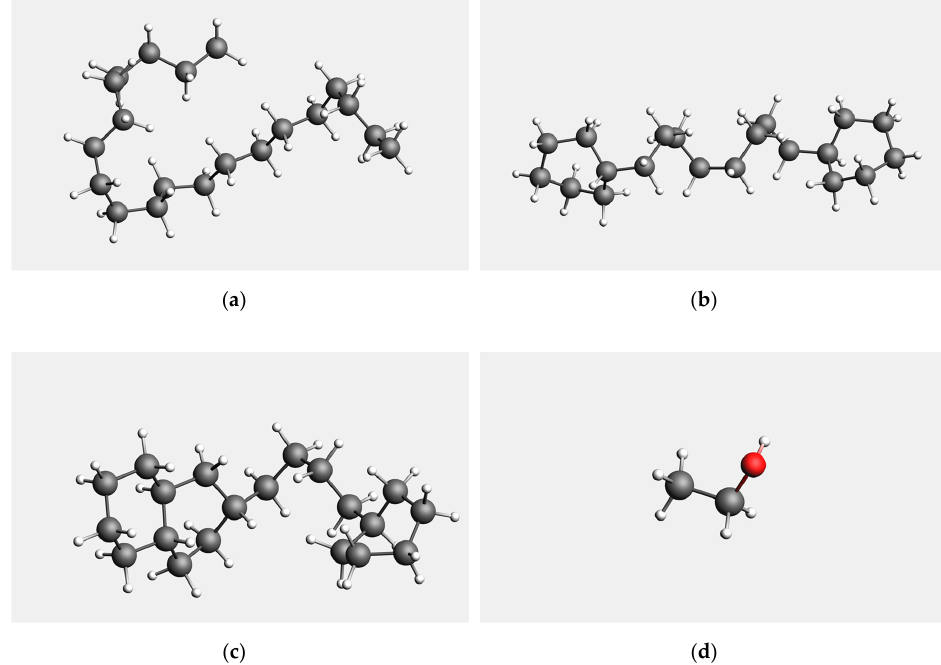
Figure 5. ( a ) The molecular model of alkanes (C 20 H 42 ); ( b ) the molecular model of bicyclic alkane (C 20 H 38 ); ( c ) the molecular model of dicyclic aromatic hydrocarbons (C 20 H 26 ); ( d ) the molecular model of ethanol.